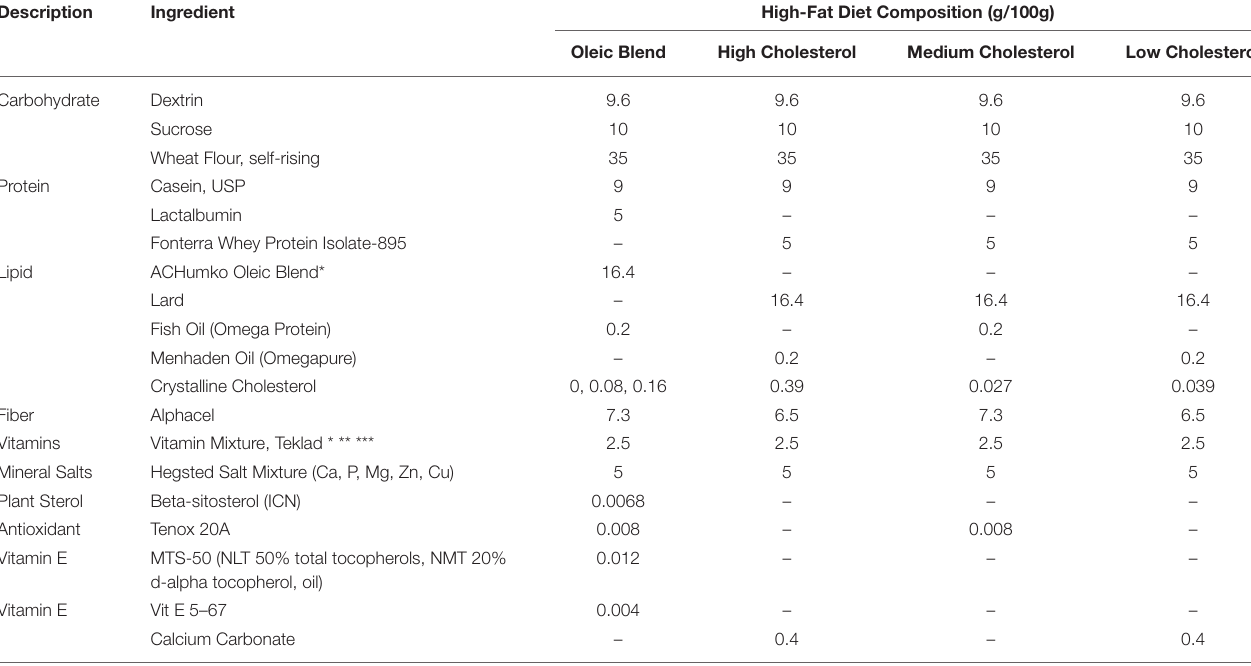
TABLE 2 | Diet composition of high-fat diets.